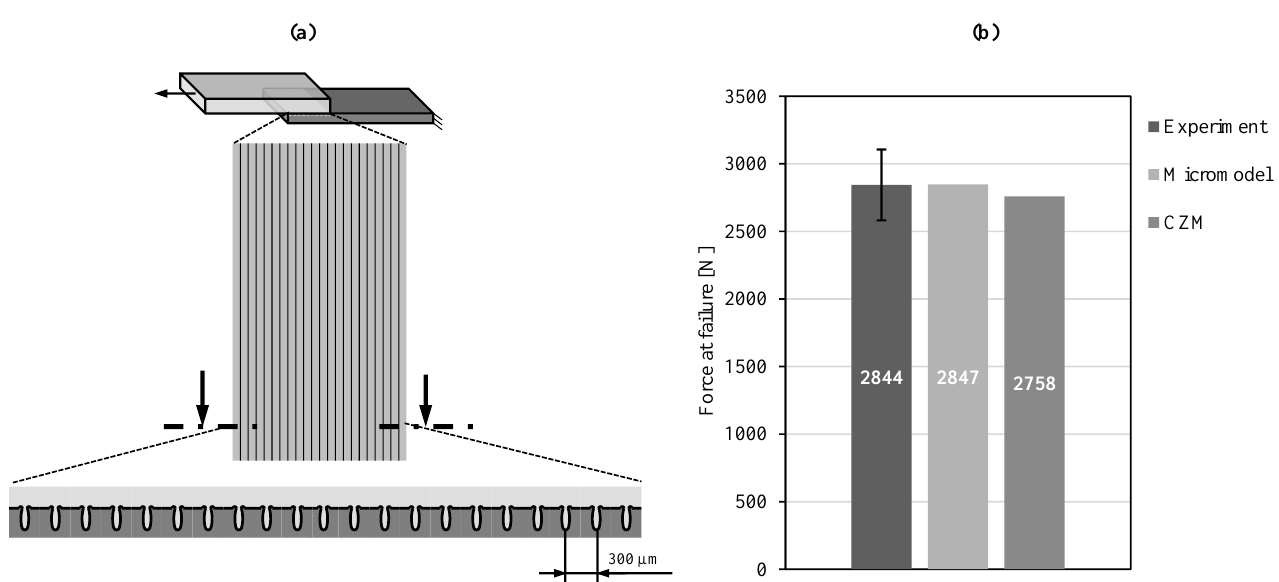
Figure 13. Comparison of the estimated force at failure for the experiment, micromodel, and CZM ( b ) for a single-lap joint with distance = 300 µm ( a ).